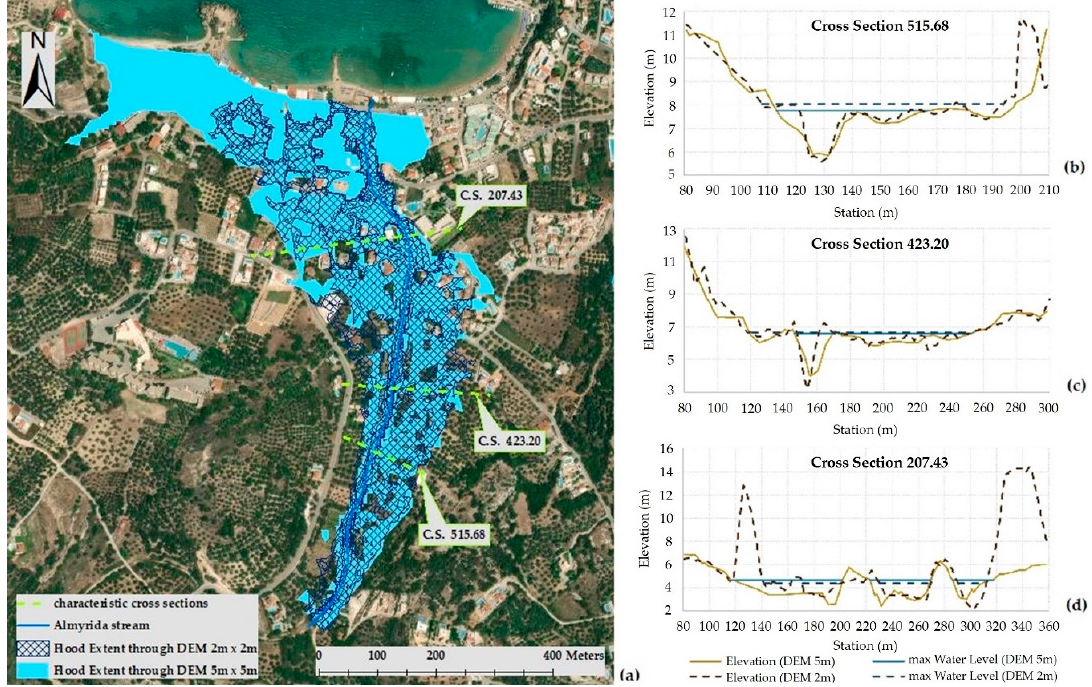
Figure 11. ( a ) Flood extent of the downstream reach of Almyrida stream as derived from DEM 2 m × 2 m (dark blue) and DEM 5 m × 5 m (light blue); Characteristic cross-sections and water level ( b ) 515.68 m before end; ( c ) 423.20 m before end; ( d ) 207.43 m before end, from both DEMs through the coupled 1D/2D HEC-RAS model.